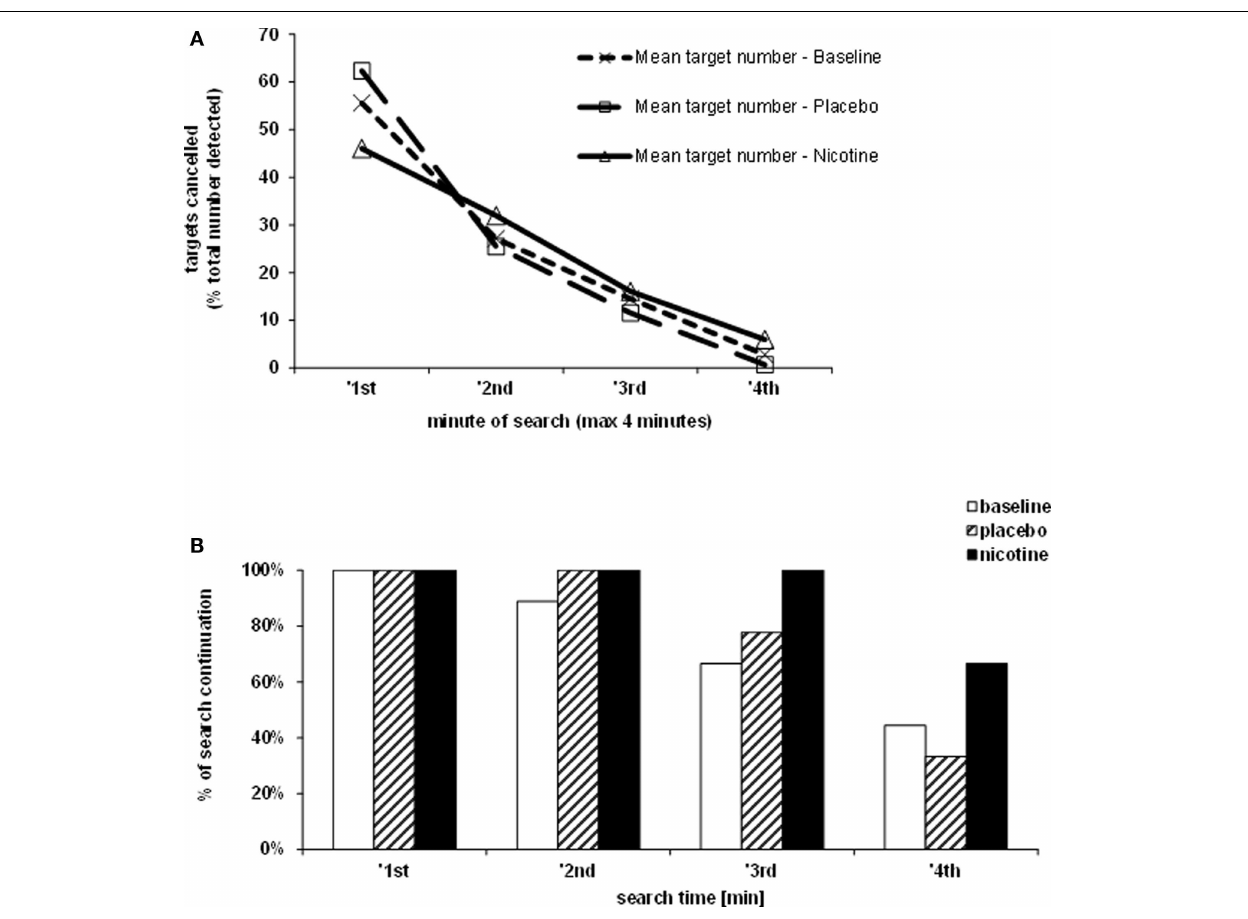
search during the Bells’ cancellation task represented as the percentage of patients continuing to search for targets in time bins and each treatment condition. Search was self-terminated until a maximum allocated time of